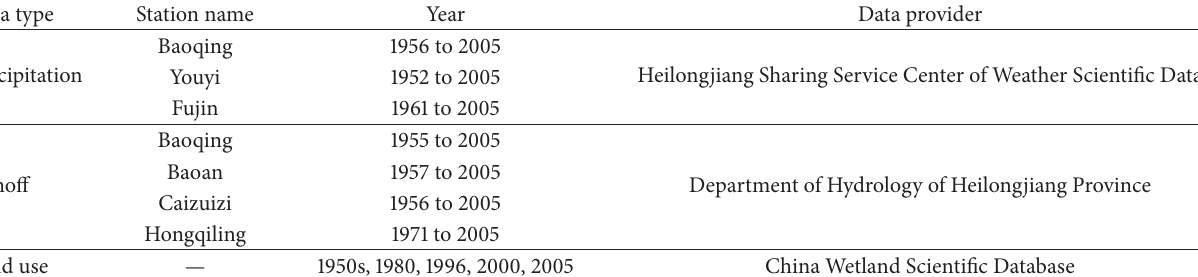
Table 1: Data sources on daily precipitation, streamflow, and land